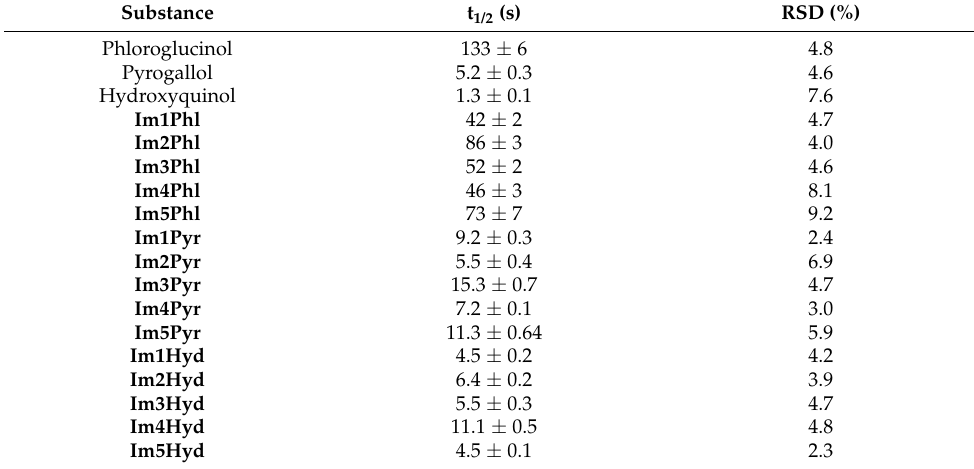
Table 4. Values of half-reaction periods for the studied compounds ( n = 5, p =